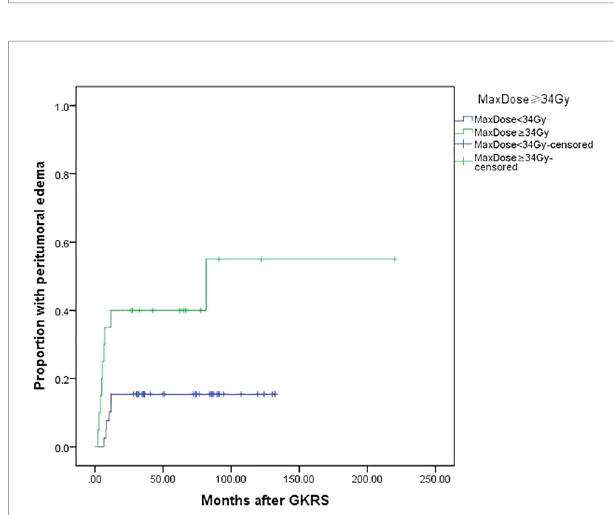
FIGURE 5 | Kaplan-Meier curve of peritumoral edema after GKRS of tumor size ≥ 25 mm vs. <25 mm. Tumor size ≥ 25 mm showed a higher peritumoral edema rate after GKRS (p=0.004).